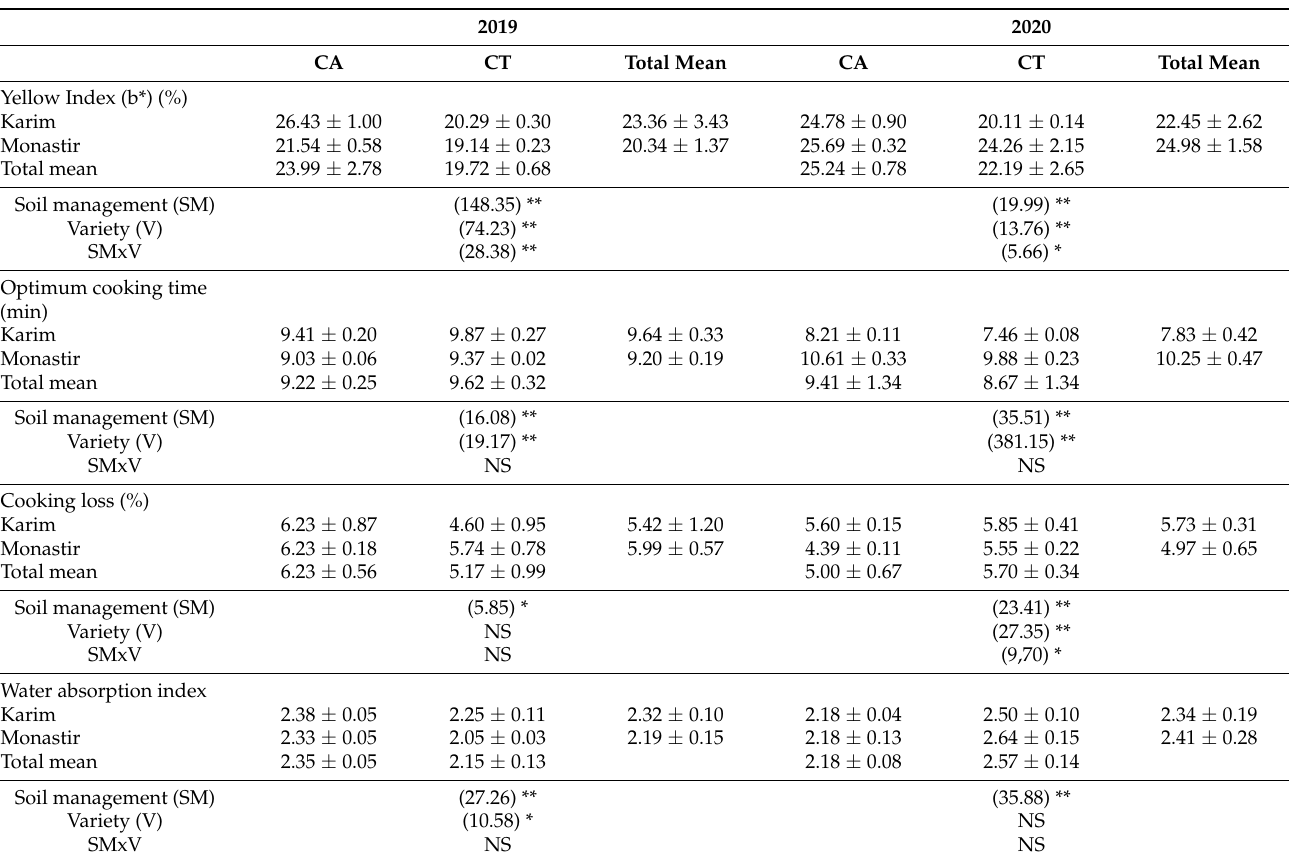
Table 4. Pasta quality of two durum wheat varieties under two soil management systems grown over two cropping